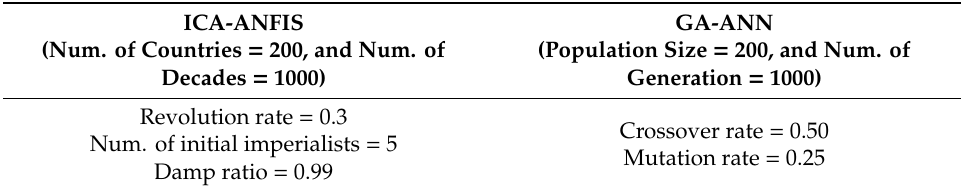
Figure 8. The incorporation of MLP with the proposed imperialist competition algorithm (ICA) and genetic algorithm (GA) algorithms. Table 2. The optimal parameters of GA and ICA algorithms.